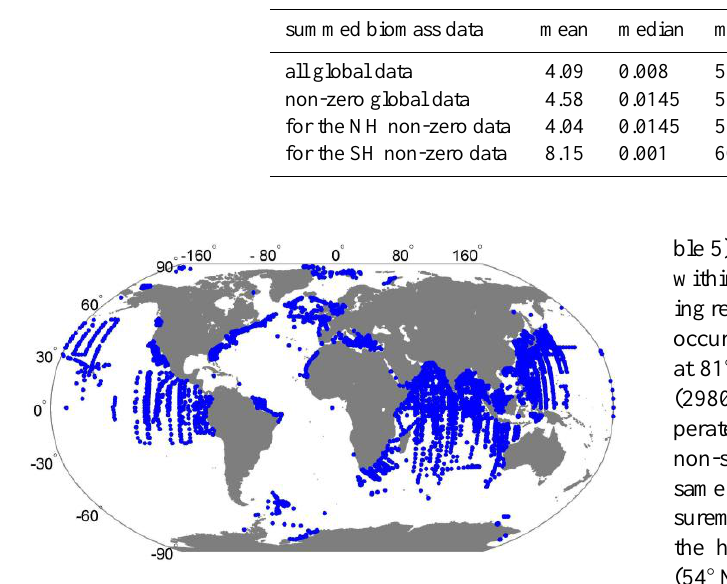
Table 3. Mean, median, maximum and minimum and standard deviation (SD) of pteropod biomass (mgCm − 3 ) determined (i) for all global data, (ii) all non-zero data points, (iii) all non-zero Northern Hemisphere (NH) data-points and (iv) all non-zero Southern Hemisphere (SH) data-points.